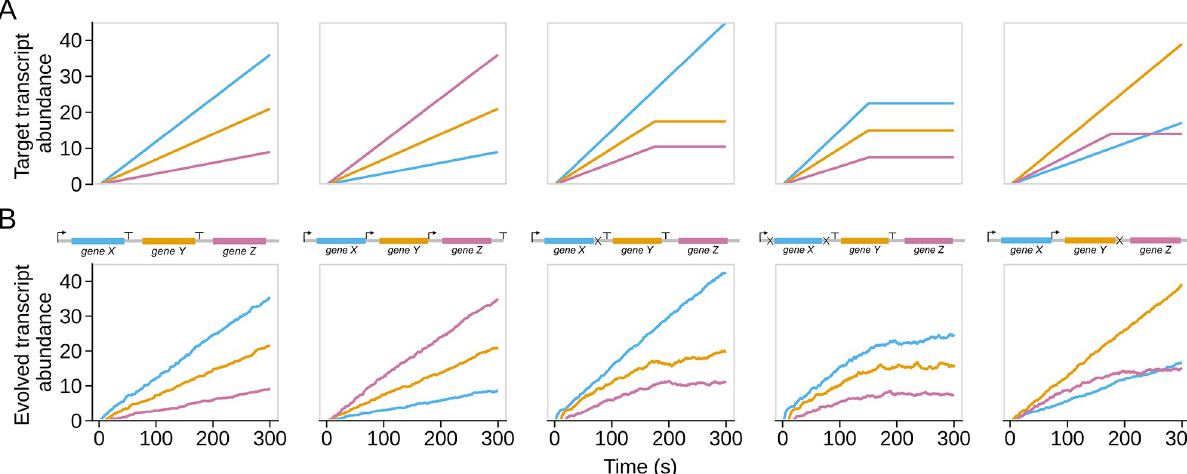
Fig 2. Examples of successfully evolved gene expression patterns. A: Each panel contains a target gene expression time-course pattern. Collectively, these patterns span a diverse range of possibilities. B: The corresponding representative gene expression patterns from successful simulations for each respective target. Shown above each time-course of gene expression is the evolved genome architecture that produced it. The architectures in the first two panels contain only promoters and terminators, while the remaining three architectures also contain RNase cleavage sites. RNase cleavage sites seem to be required for any regulatory patterns that go beyond a simple linear increase in expression level over